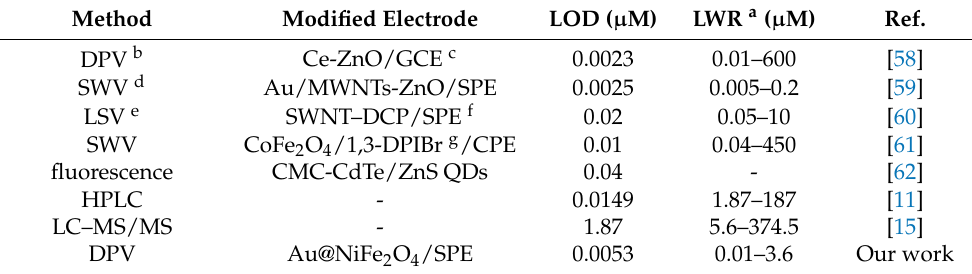
Table 2. Detection figures of merit for other methods for EPR reported in the